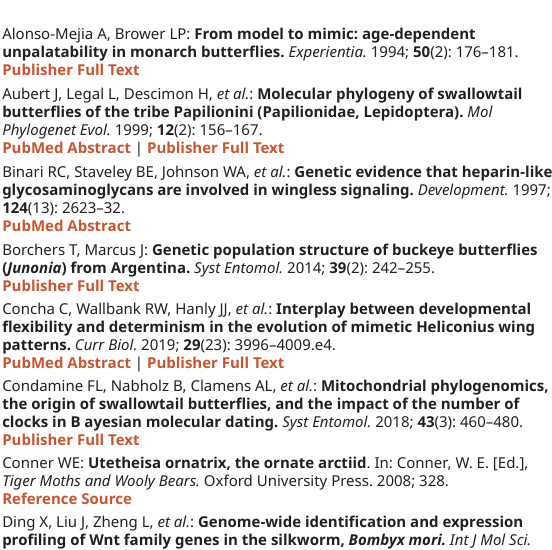
Table S1. Details concerning heparin injections for the